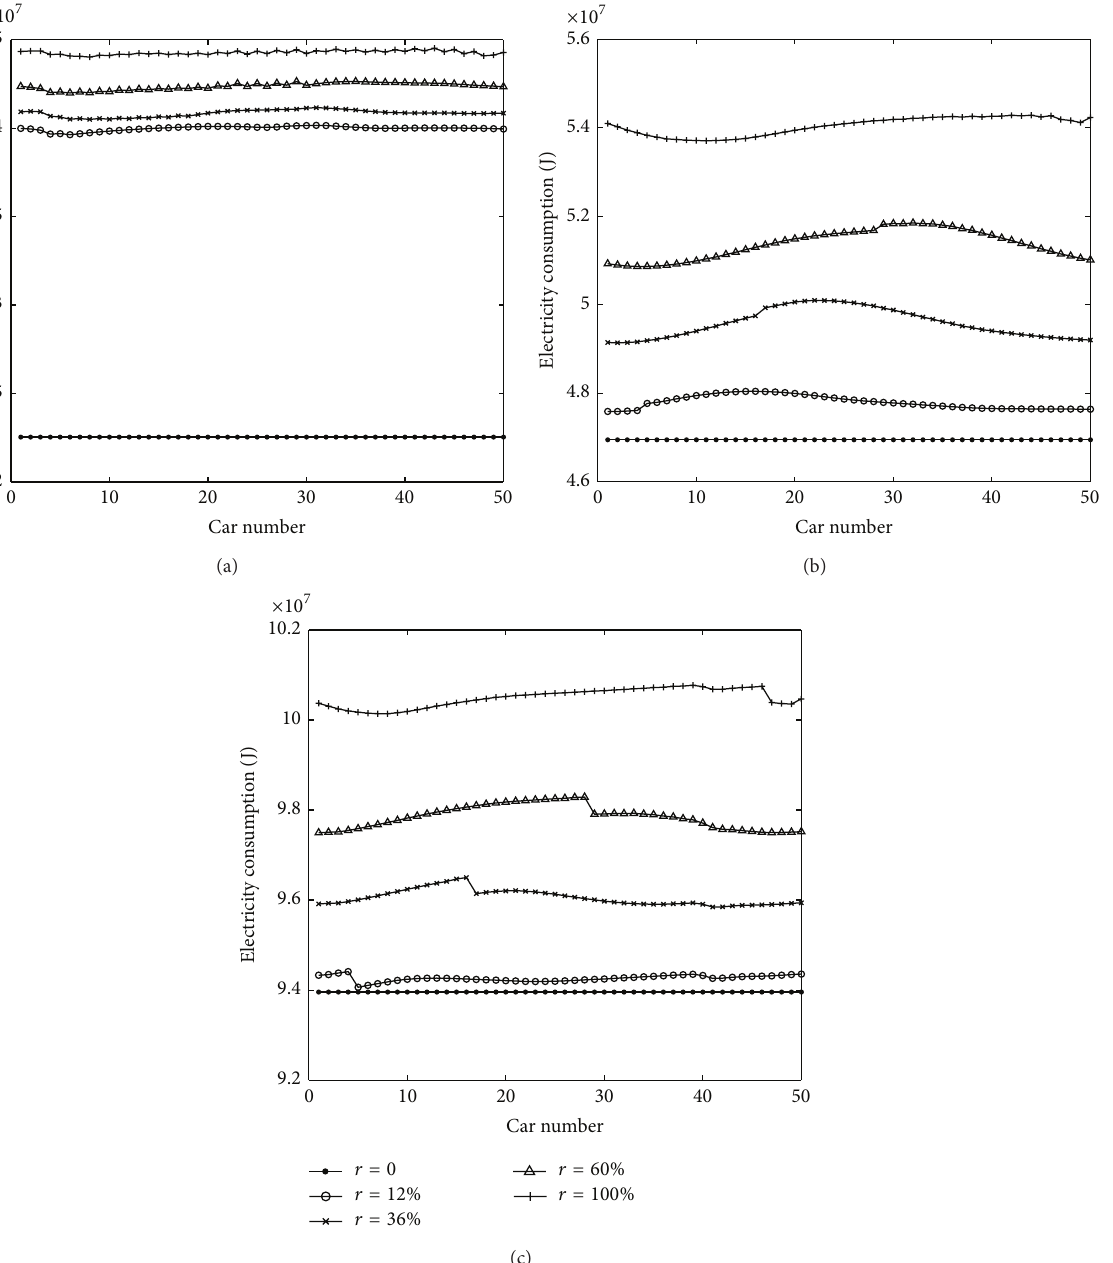
Figure 7: The total electricity consumed by each vehicle when the distance between the two charging stations is 500 m, where (a) Δ𝑥 0 = 20 m, (b) Δ𝑥 0 = 40 m, and (c) Δ𝑥 0 = 80